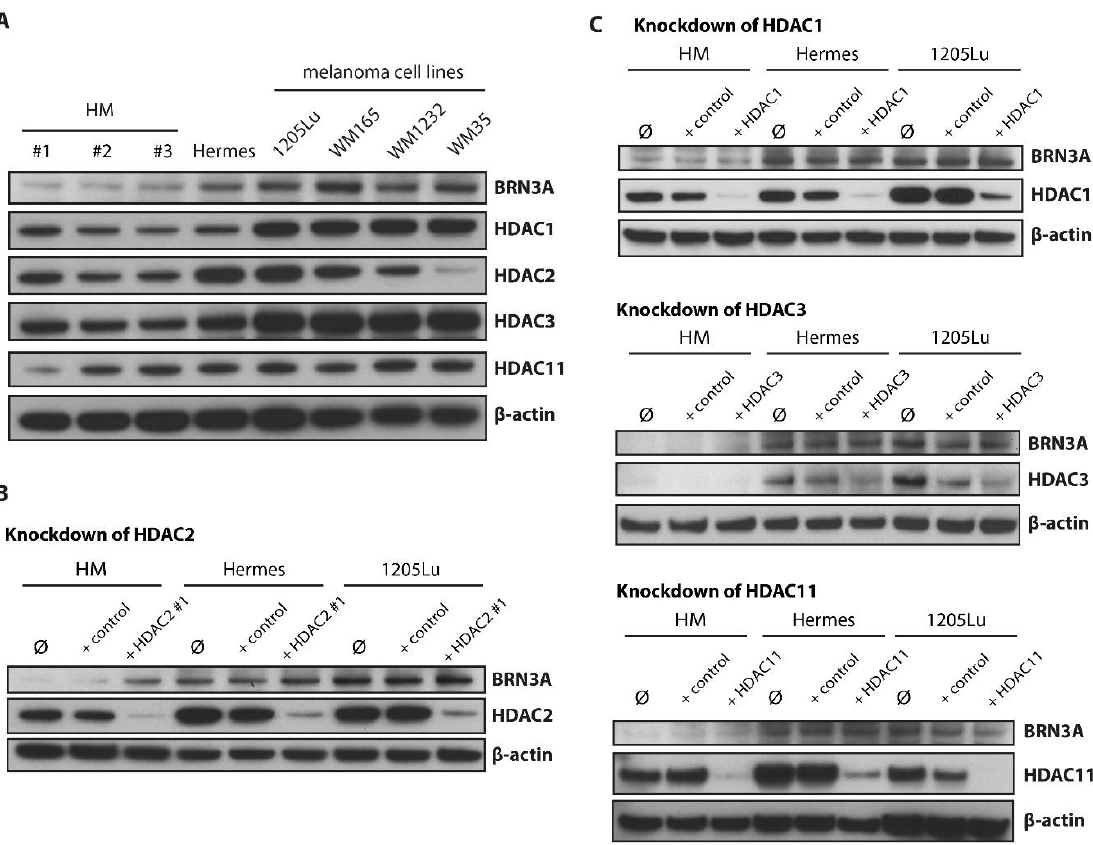
Figure 5. HDAC2 inhibition induced BRN3A expression in melanocytes and melanoma cells. ( A ) Basal protein expression of HDAC1, HDAC2, HDAC3, and HDAC11, in HM (3 donors), Hermes, and melanoma cell lines (1205Lu, WM165, WM1232, and WM35). ( B ) Protein expression of BRN3A and HDAC2 48 h after siRNA-mediated transient knockdown of HDAC2 in melanocytes (HM, Hermes) and melanoma cells (1205Lu). HDAC2 #1: HDAC2 siRNA. BRN3A induction upon HDAC2 inhibition was also confirmed by a second siRNA (HDAC2 #2, see Supplementary Figure S3A); control: non-targeting control siRNA; Ø: transfection reagent only (HM, Hermes: JetPrime; 1205Lu: Lipofectamine RNAiMAX). ( C ) Protein expression of BRN3A as well as HDAC1, HDAC3, and HDAC11 48 h after knockdown of HDAC1, 3, and 11, respectively, in melanocytes (HM, Hermes) and melanoma cells (1205Lu). HDAC1, HDAC3, and HDAC11: specific siRNAs targeting HDAC1, 3, and 11, respectively; control: non-targeting control siRNA; Ø: transfection reagent only (HM, Hermes: JetPrime; 1205Lu: Lipofectamine RNAiMAX). Representative immunoblots are shown. To investigate if HDAC2 inhibition alters the acetylation of its target histones at DNA regulatory elements that specifically regulate BRN3A , we mapped the binding regions of acetylated lysine 27 residues at histone H3 (H3K27ac) using chromatin